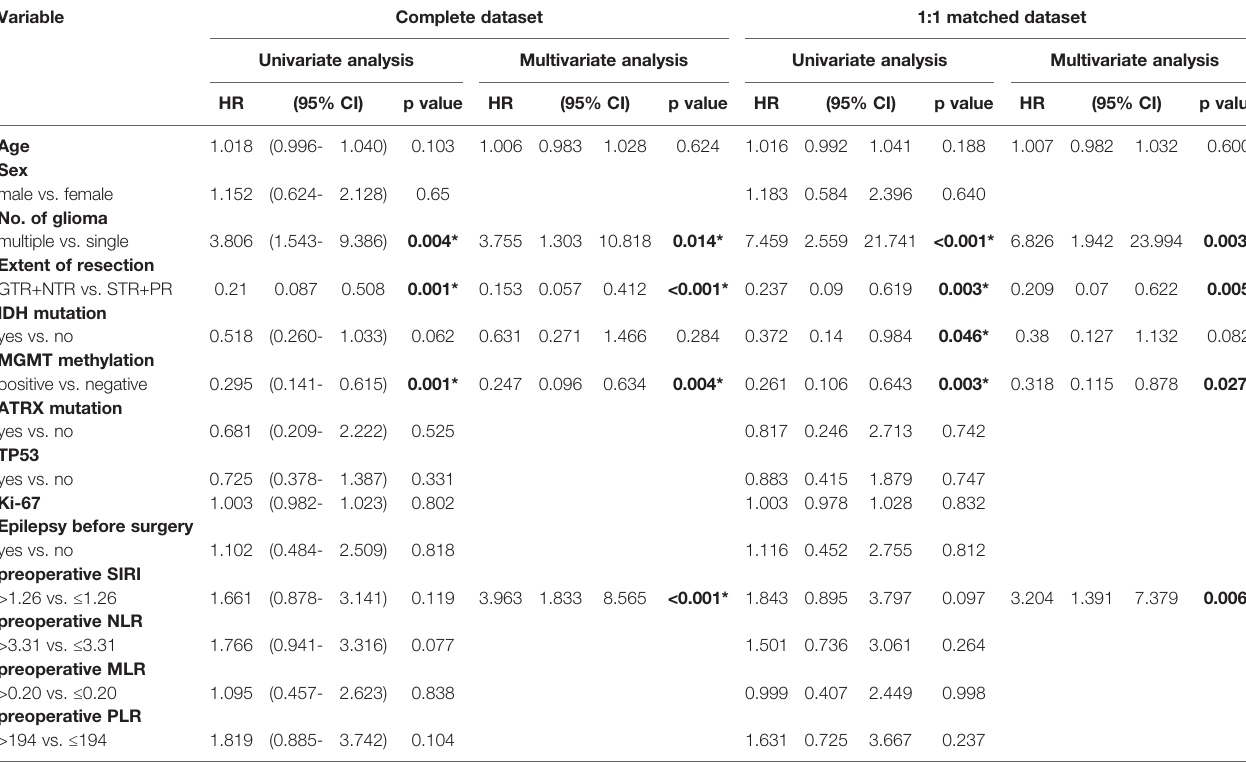
TABLE 3 | Univariate and multivariate cox regression analyses for overall survival in grade IV glioma.